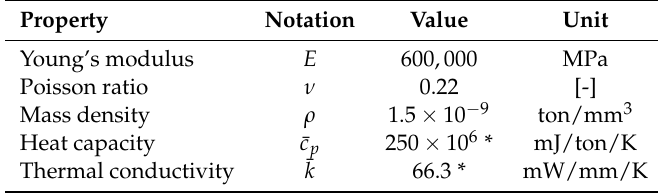
Table 3. Mechanical and physical properties of cutting tool (Sandvik H13A)